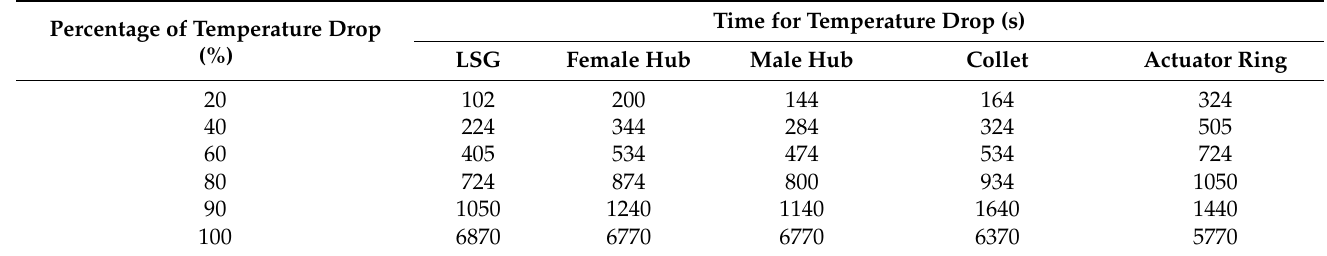
Table 4. The time required for each component to drop to the seawater temperature under the working condition of instantaneous temperature drop.